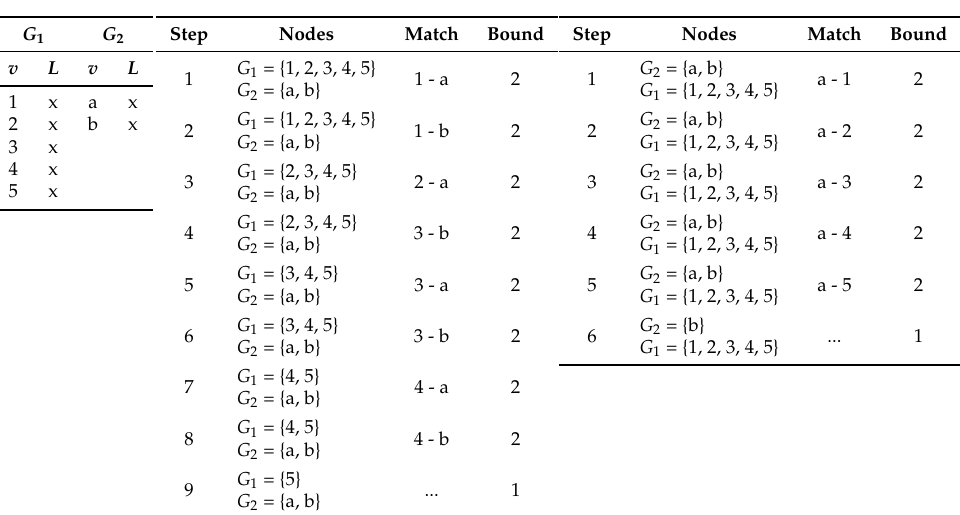
Table 3. An example to illustrate the pruning effect of a smart bidomain sorting heuristic. a